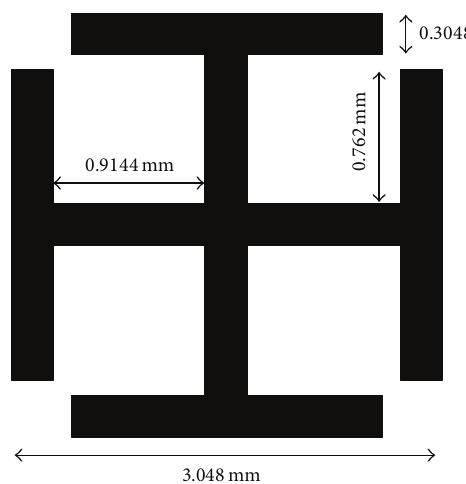
Figure 3: Reference UC-EBG geometry [3].